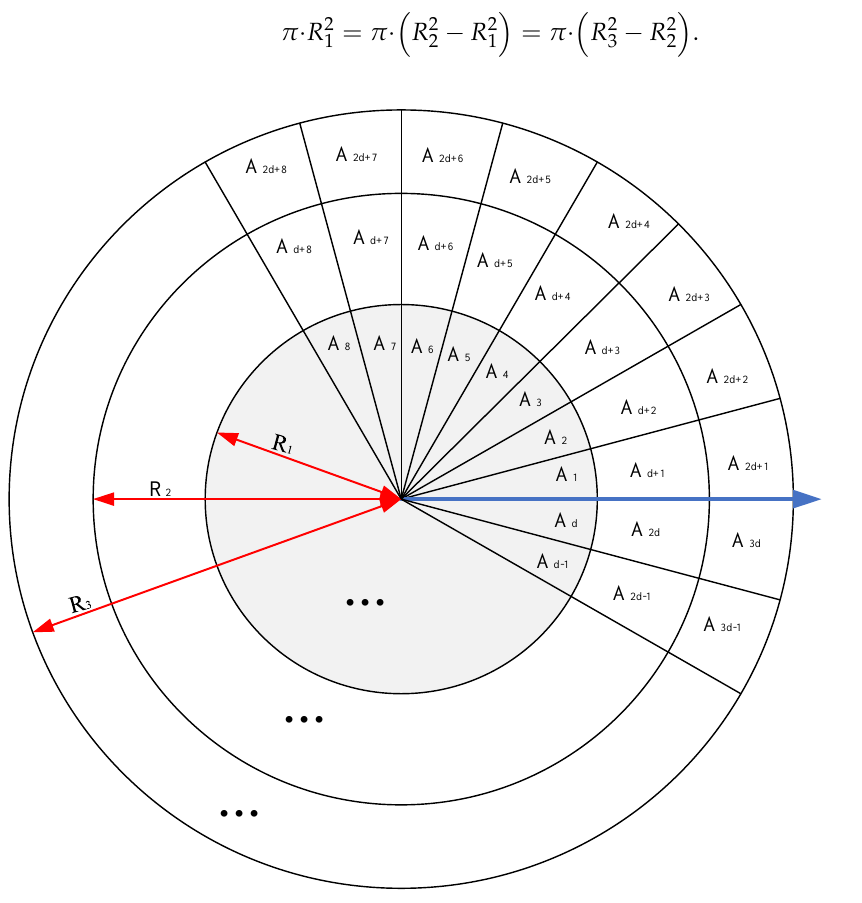
Figure 3. The modified GLOH.